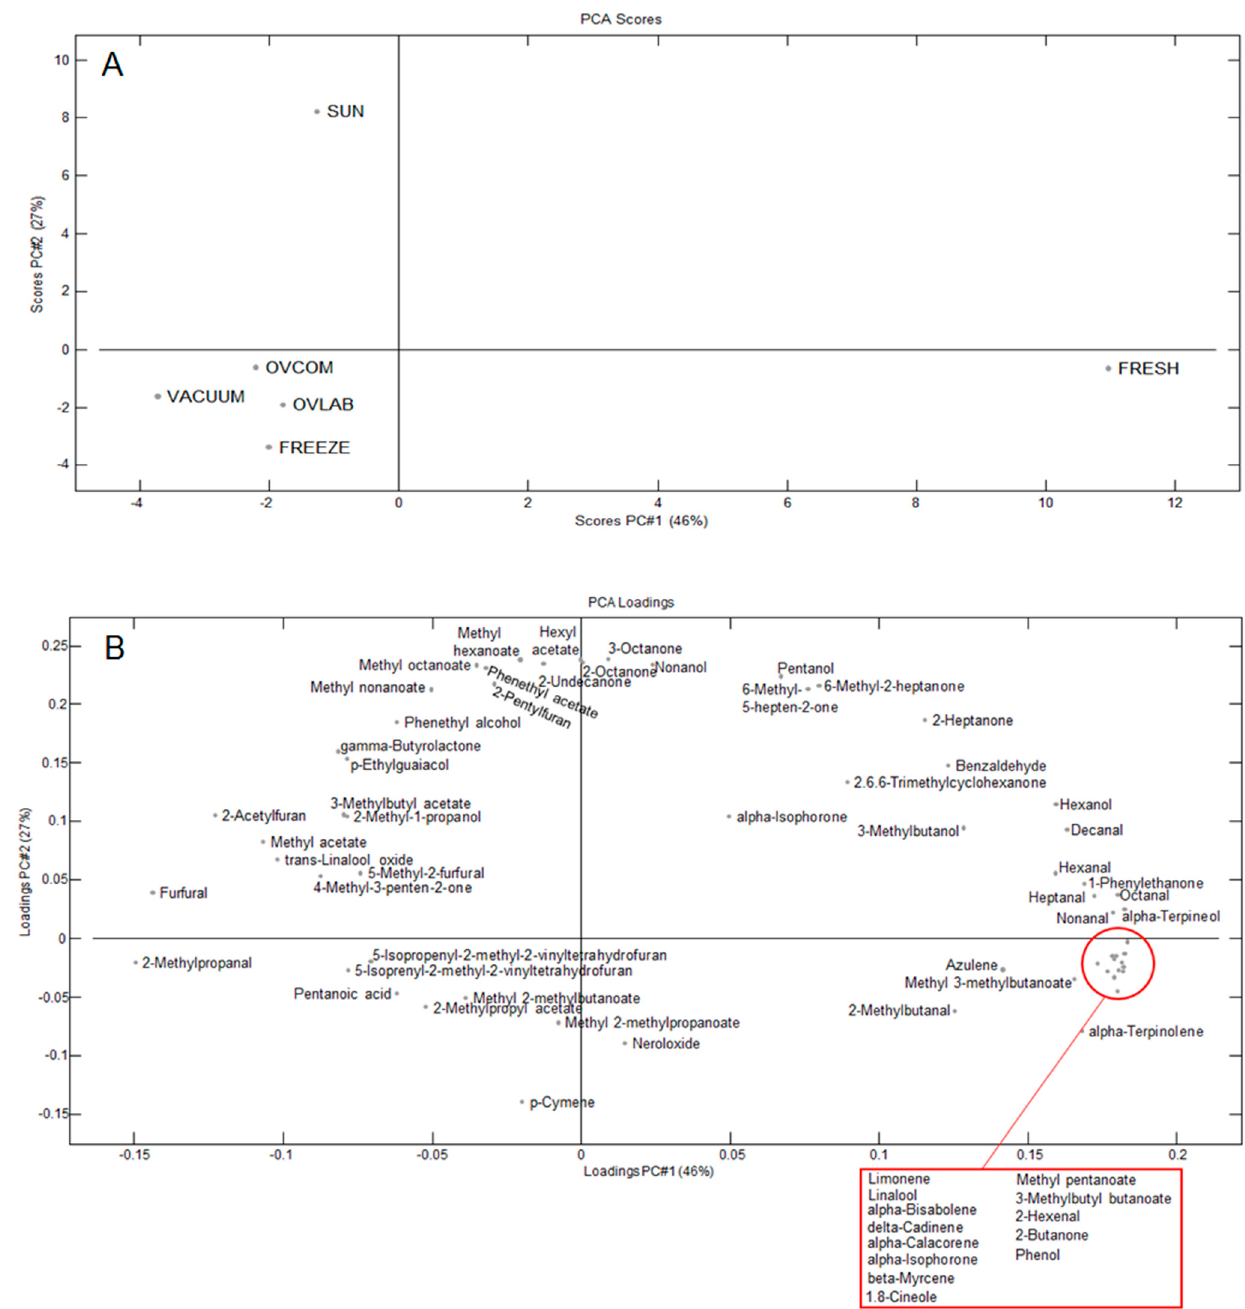
Figure 1. PCA ( A ) scores and ( B ) loadings plots of based on average significant ( p < 0.05) peak areas of volatile compounds for fresh and dried roselle ( Hibiscus sabdariffa L.) calyx samples.